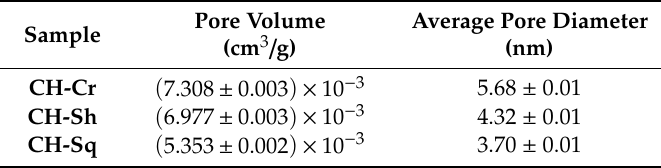
Table 3. Porosity parameters for CH-Cr, CH-Sh, and